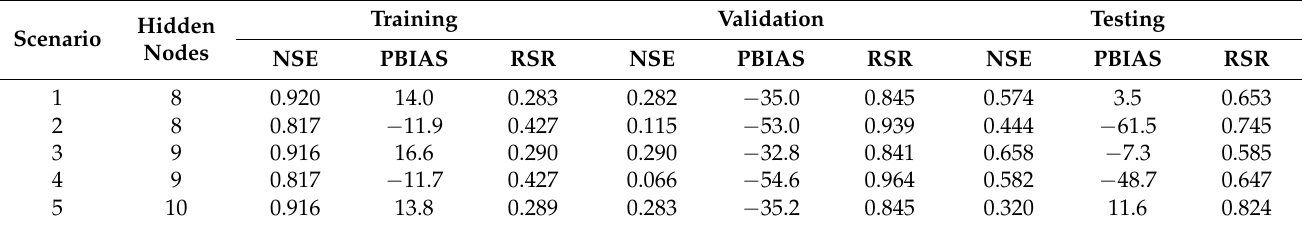
Table 6. BlockedCV selected models with the optimum number of hidden nodes,